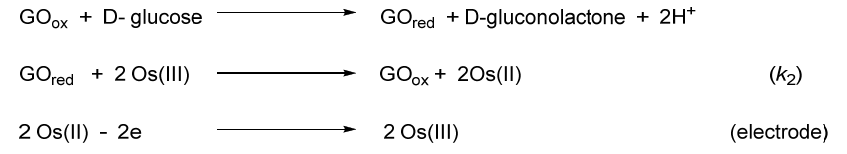
Figure 46. Electron transfer pathway between osmium shuttle and glucose oxidase (GO). Table 3. Reduction potential (Os II /Os III ) and rate constants k 2 for the electron transfer between osmium complexes and the active site of glucose oxidase (GO). Reference electrode Ag/AgCl. [Os] 20